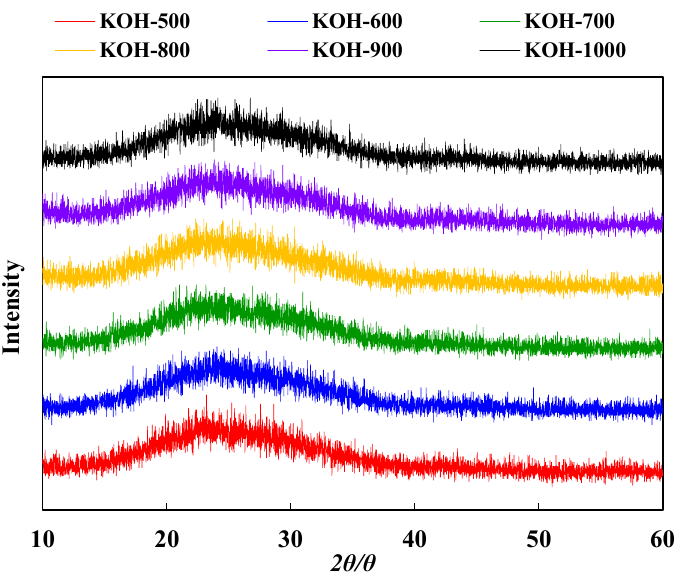
Figure 7. XRD patterns of ACs prepared at different activation